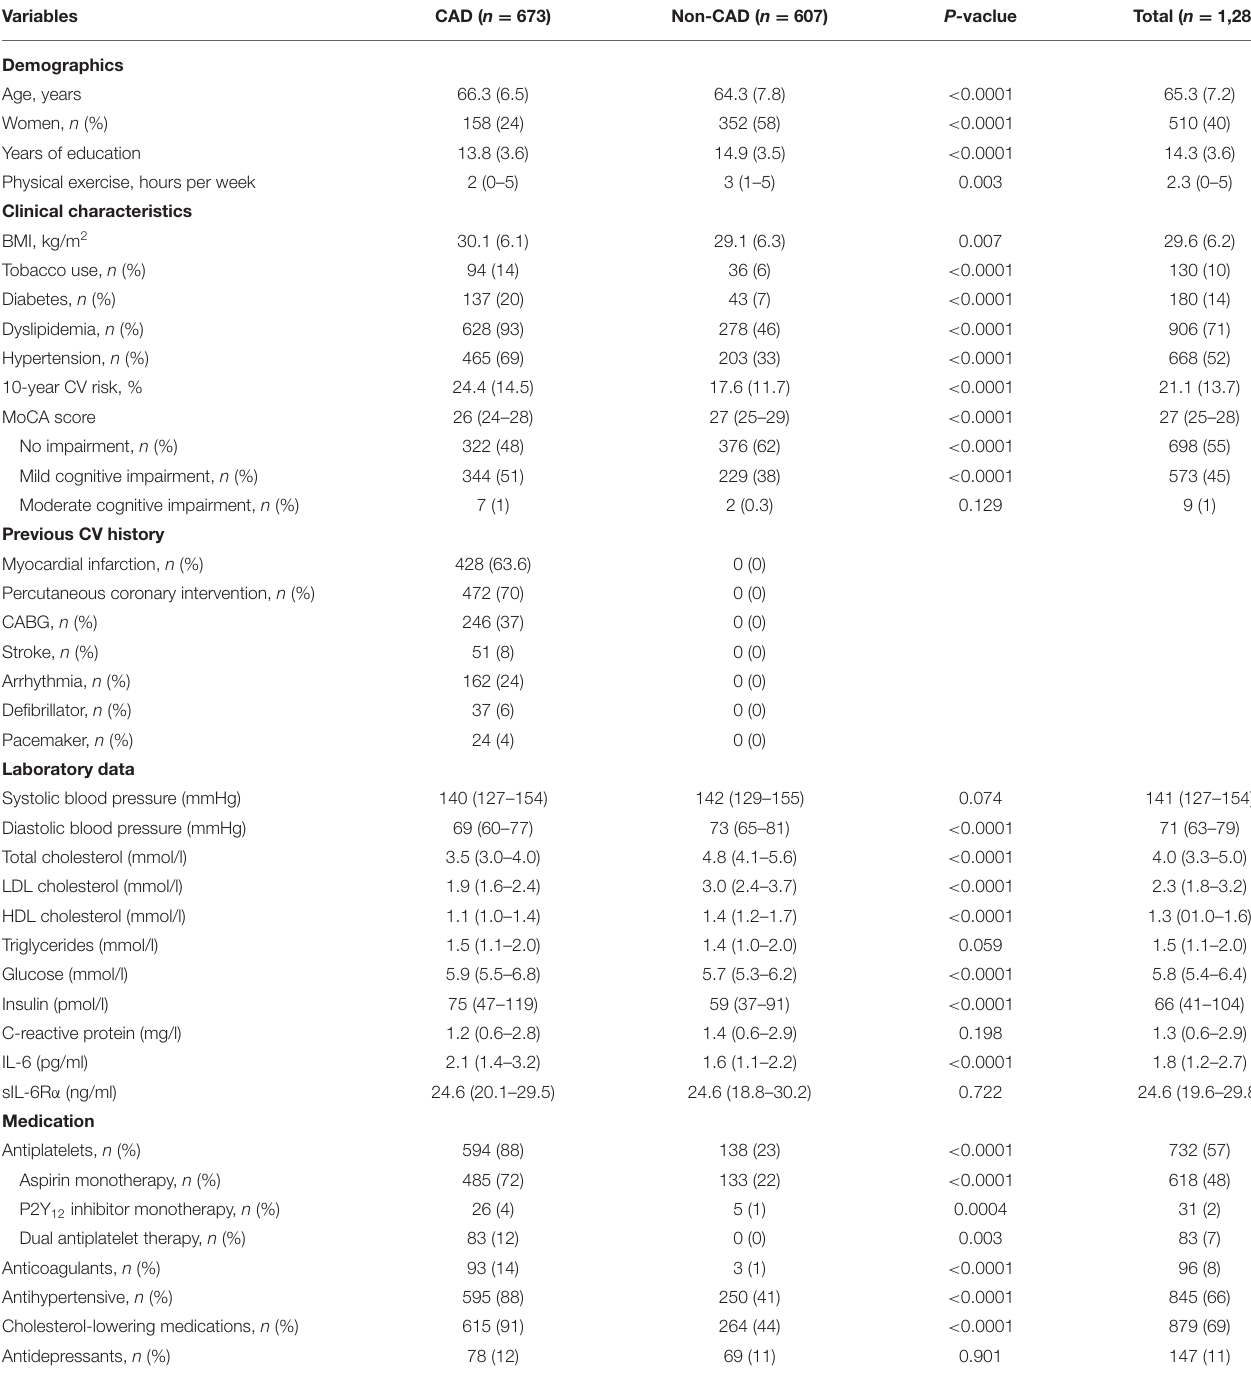
TABLE 1 | Baseline characteristics.